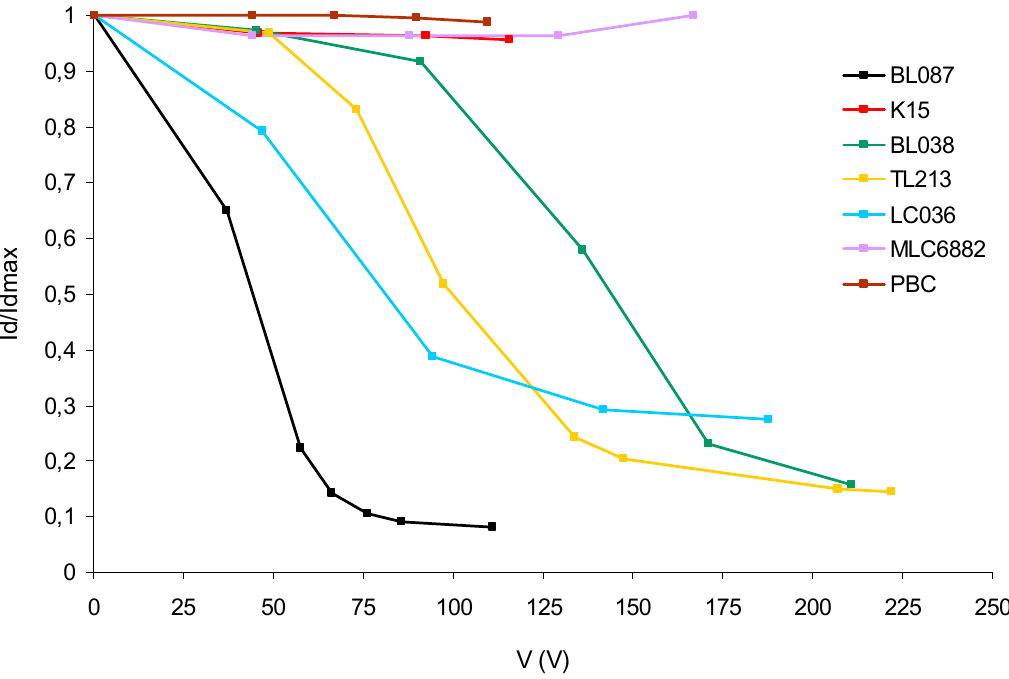
Figure 6. Diffracted light intensity divided by the maximum diffracted light intensity versus RMS voltage for each HPDLC device after the bleaching process.